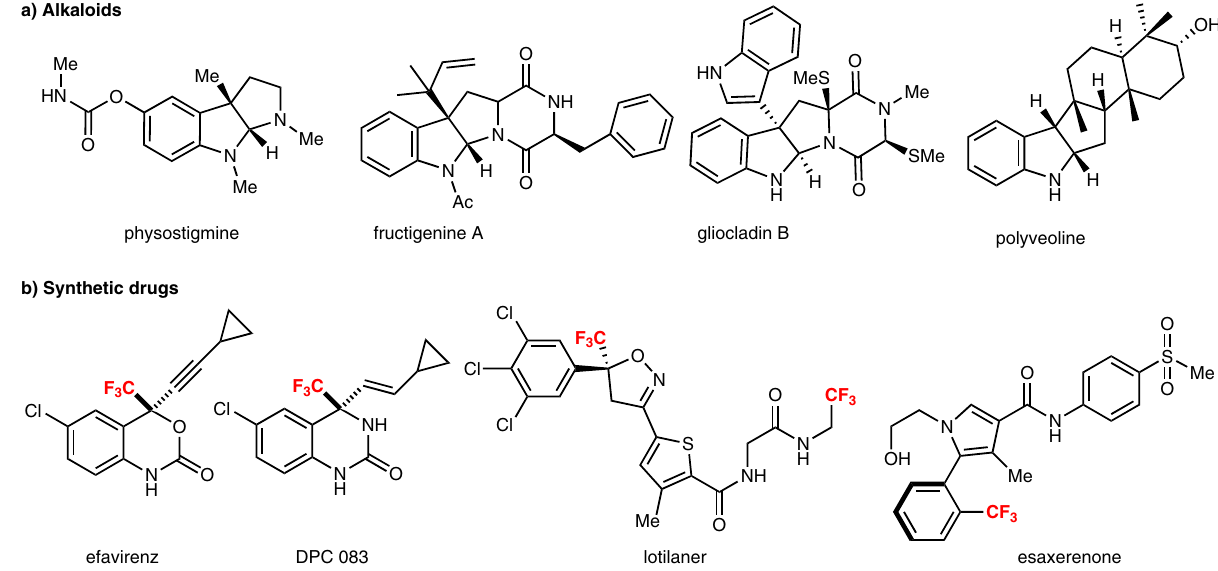
Fig. 1 Examples of biologically active N -heterocycles. a Representative biologically active alkaloids with polycyclic indole/indoline scaffolds. b Representative synthetic drugs (pharmaceuticals and agrochemicals) with a CF 3 group at a stereogenic carbon